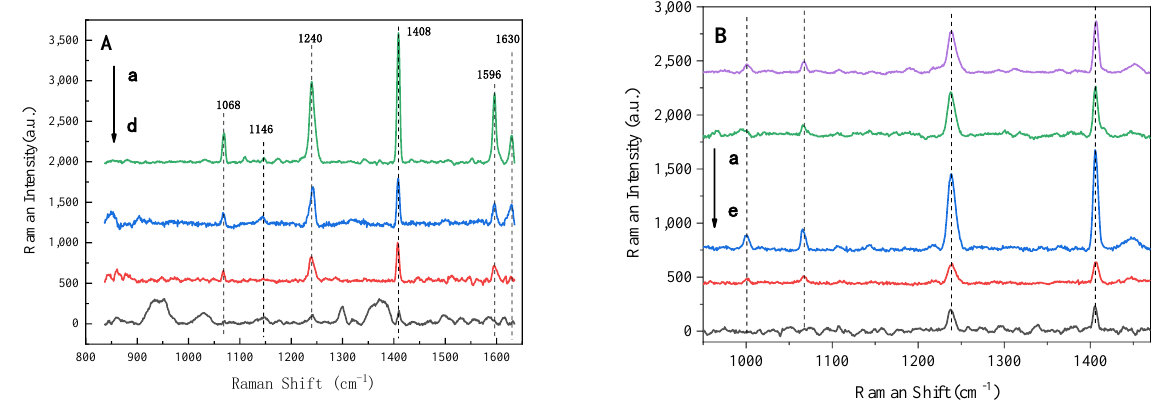
Figure 3. ( A ). SERS spectrum of pyrene – ethanol solution with a concentration of 100 uM after dripping a volume of 10 μ L on KBr — (a), KI — (b), NaBr-modified — (c) and unmodified — (d) RGB-SERS substrate for SERS detection; ( B ). SERS spectrum of pyrene – ethanol solution with a concentration of 10 μ M after dripping a volume of 10 μ L on the KBr-modified RGB-SERS substrate for SERS detection. Spectra (a – e) represent 30, 20, 10, 5, and 1 mM KBr, respectively.